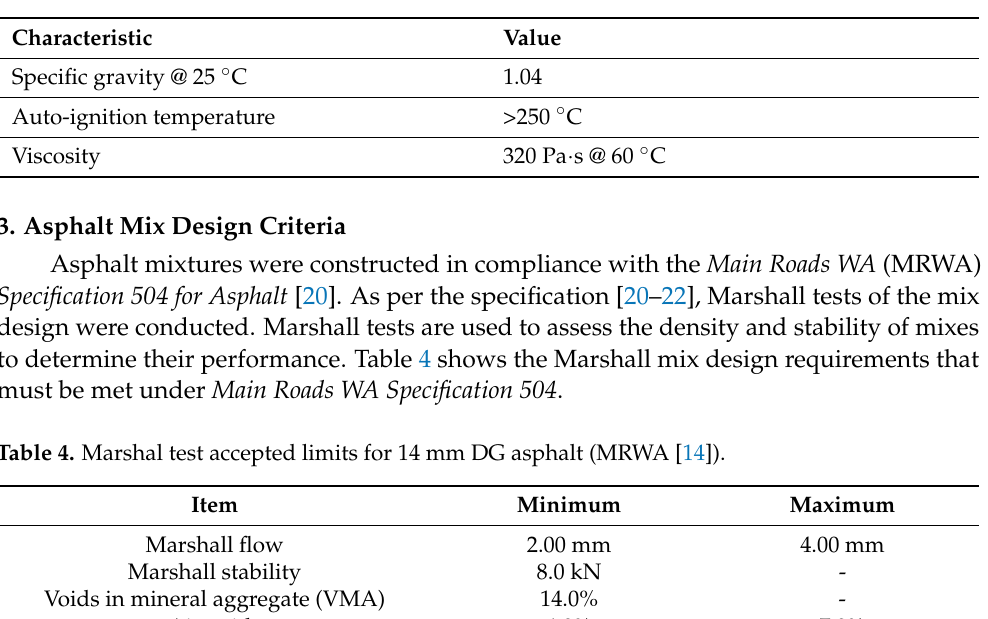
Table 3. Bitumen characteristics [18].